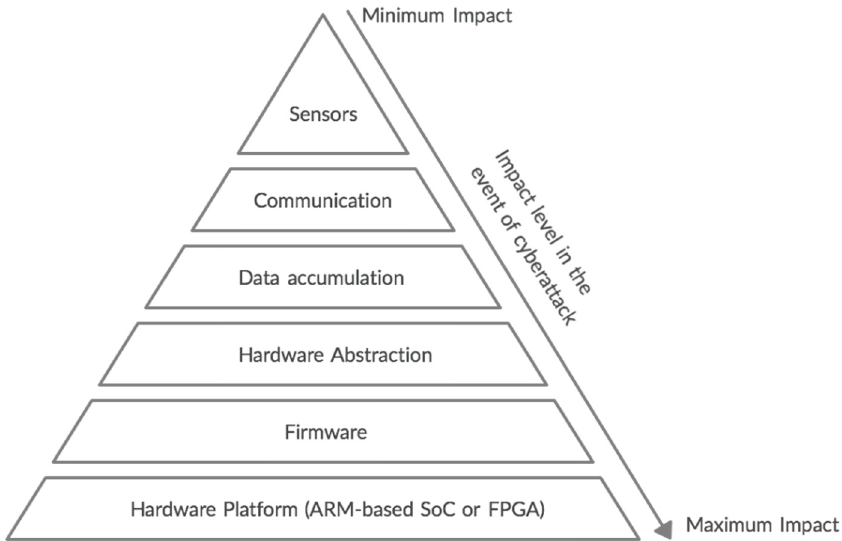
Figure 1. “Pyramid of Pain”, based on vulnerability Figure 1. “ Pyramid of Pain”, based on vulnerability analysis.